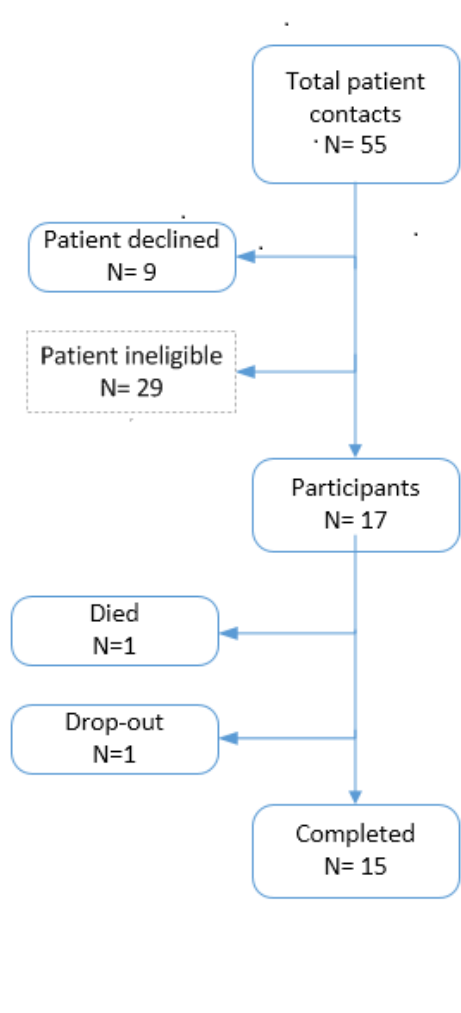
Figure 1. Study enrollment and